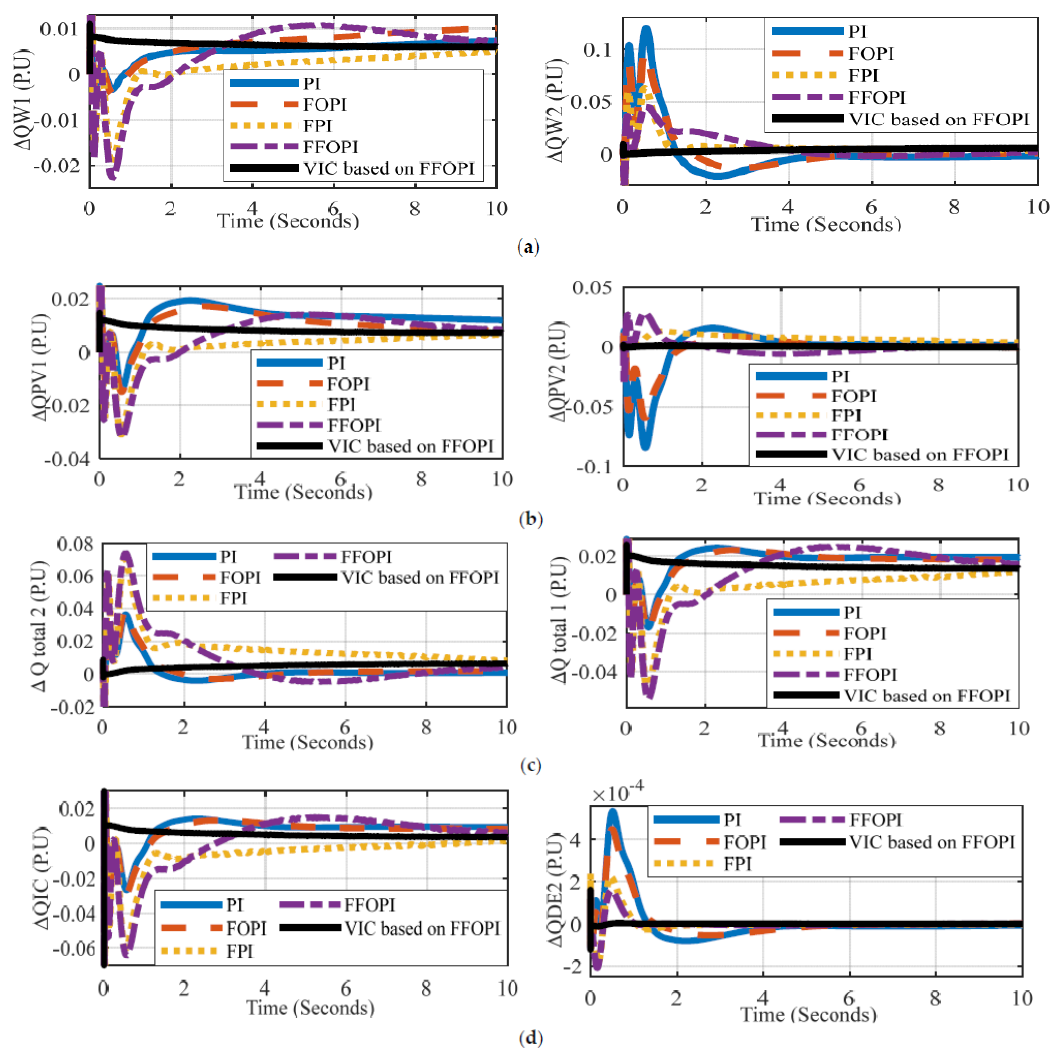
Figure 14. M 1 and M 2 ’s reactive power measurements versus time for each controller at wind speed disturbance: ( a ) ∆ Q w1 (PU), ∆ Q W2 (PU), ( b ) ∆ Q PV1 (PU), ∆ Q PV2 (PU), ( c ) ∆ Q total 1 (PU), ∆ Q total 2 (PU), ( d ) ∆ Q IC (PU), ∆ Q DE2